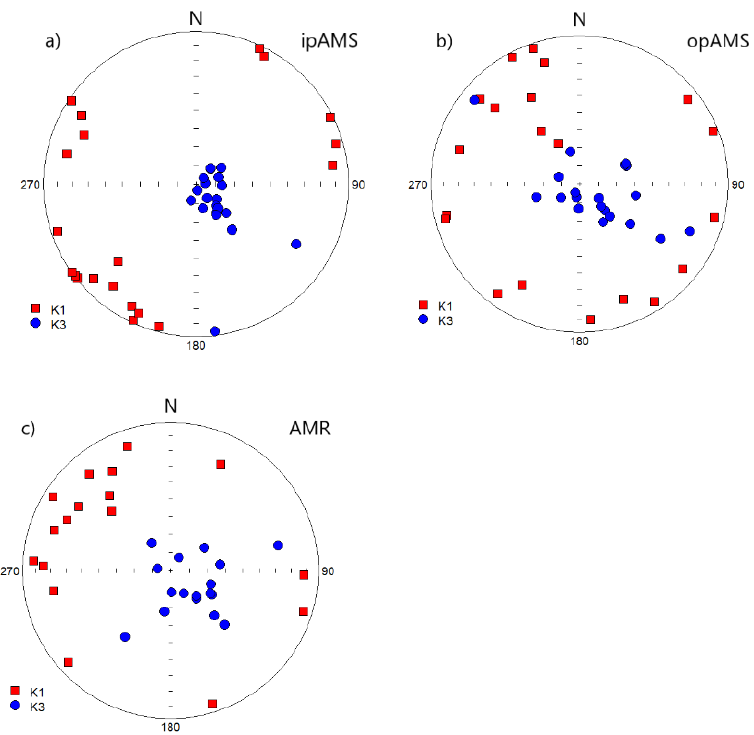
Figure 14. Orientations of magnetic foliation poles (Min) and magnetic lineations (Max) in Skorušina Hills sedimentary rocks: ( a ) ipAMS, ( b ) opAMS, ( c ) AMR. Tilt corrected coordinate system, equal area projection on lower hemisphere. Adapted from [46].